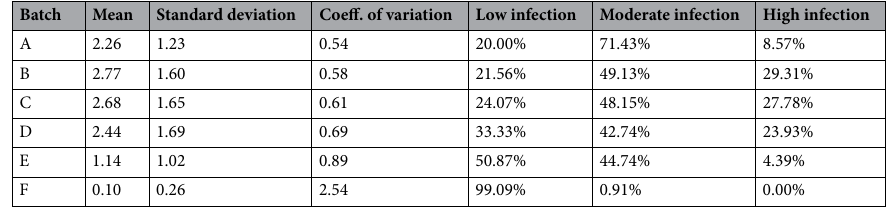
Table 2. A summary statistics of diagnosis of sepals across the 6 batches of tomatoes used in the experiments.